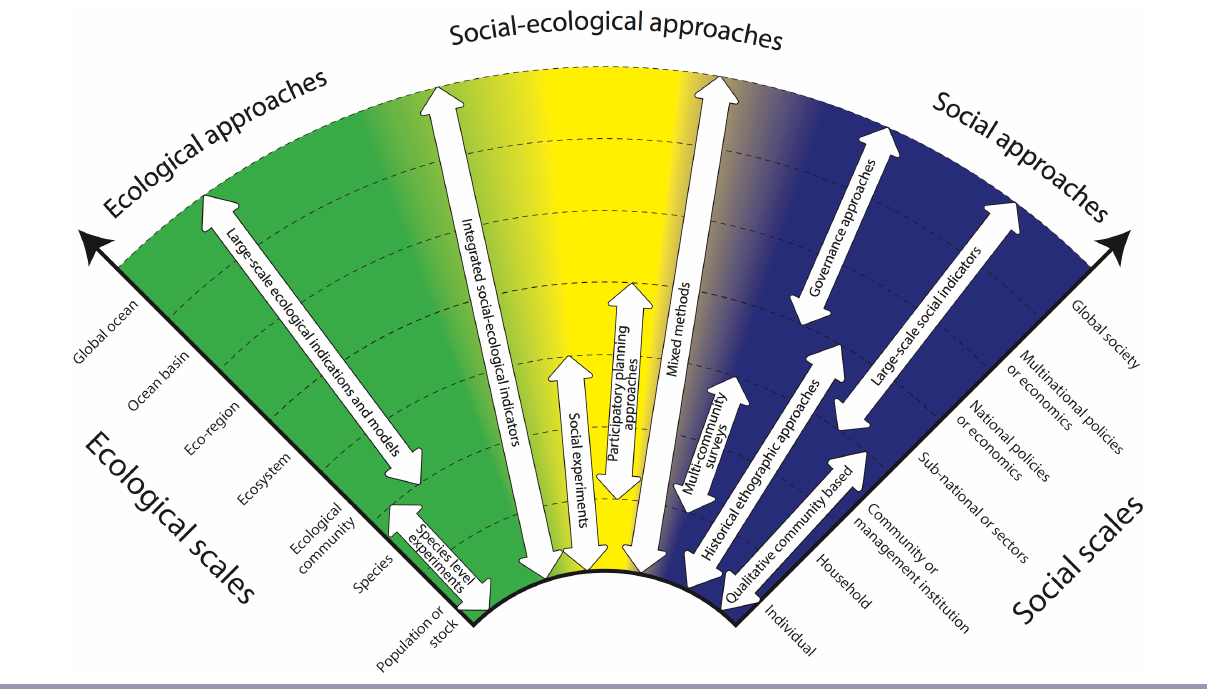
Fig. 1. Comparison of 11 approaches for assessing adaptive capacity at different spatial scales and with varying attention to social and ecological